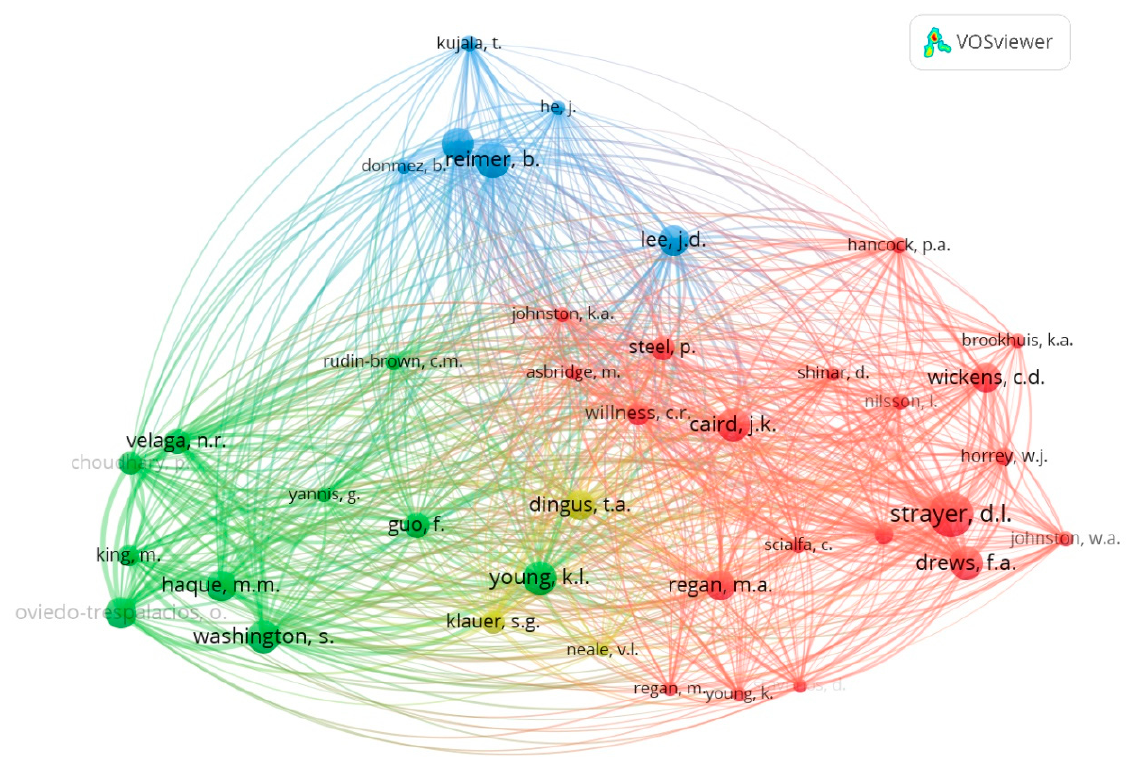
Figure 5. Author co-citations network.